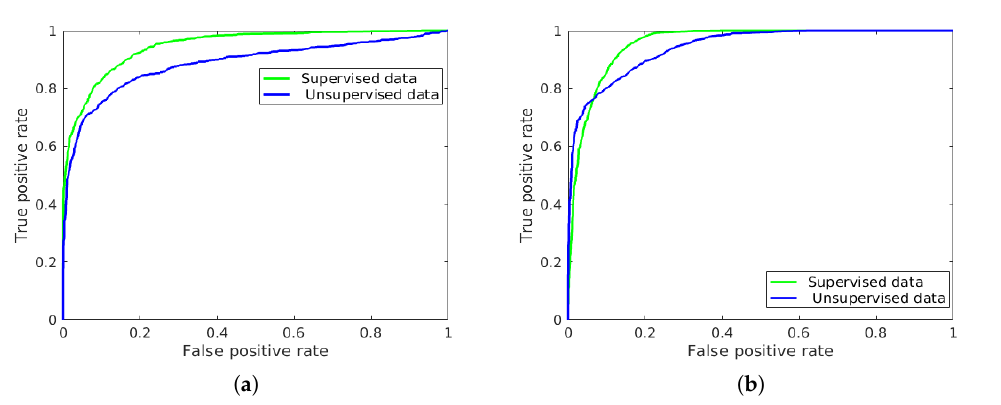
Figure 10. Receiver operating characteristic (ROC) curves of the test data with unsupervised and supervised data labeling. From left to right, the ROC curves computed on the bean ( a ) and spinach ( b ) test data. In the bean field, the areas under the curve (AUCs) are 88.73% for unsupervised data and 94.84% for supervised data. In the spinach field, the AUCs are 94.34% for unsupervised data and 95.70% for supervised data. Supervised and unsupervised data mean, respectively, data labeled in supervised and unsupervised